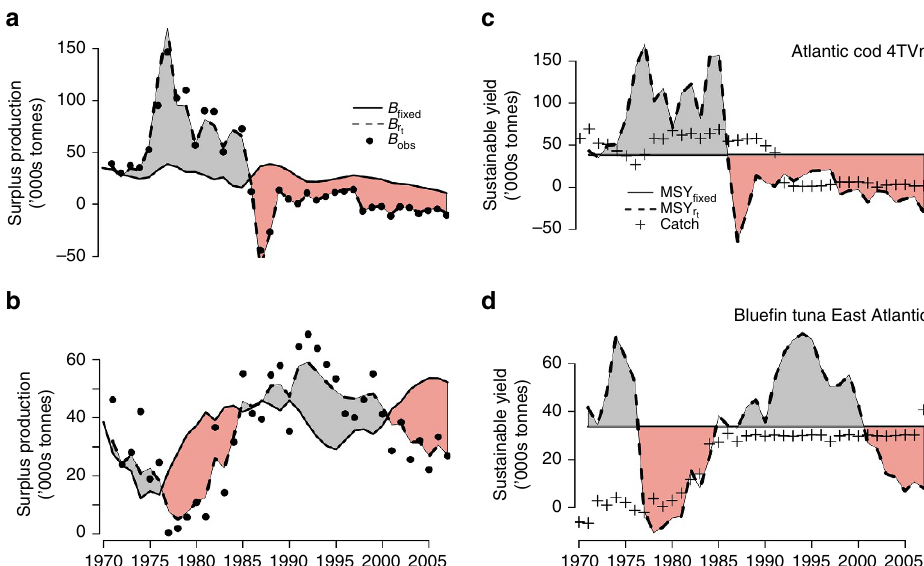
Figure 2 | Examples of non-stationary productivity. Two example stocks are shown: Atlantic cod from the Southern Gulf of St. Lawrence in Canada, fisheries region 4TVn ( a , c ) and bluefin tuna from the East Atlantic ( b , d ). ( a , b ) The annual surplus production for each stock (circles are observed values, B obs , solid line is biomass-predicted from the stationary model with fixed r , denoted B fixed , and the dashed line is the biomass-predicted from the non-stationary model, B rt ). ( c , d ) The theoretical maximum sustainable yield (crosses are recorded catches). Grey shading indicates when productivity is higher than would be predicted based on a static productivity model (potential underfishing) and red shading indicates lower-than-expected productivity that would promote